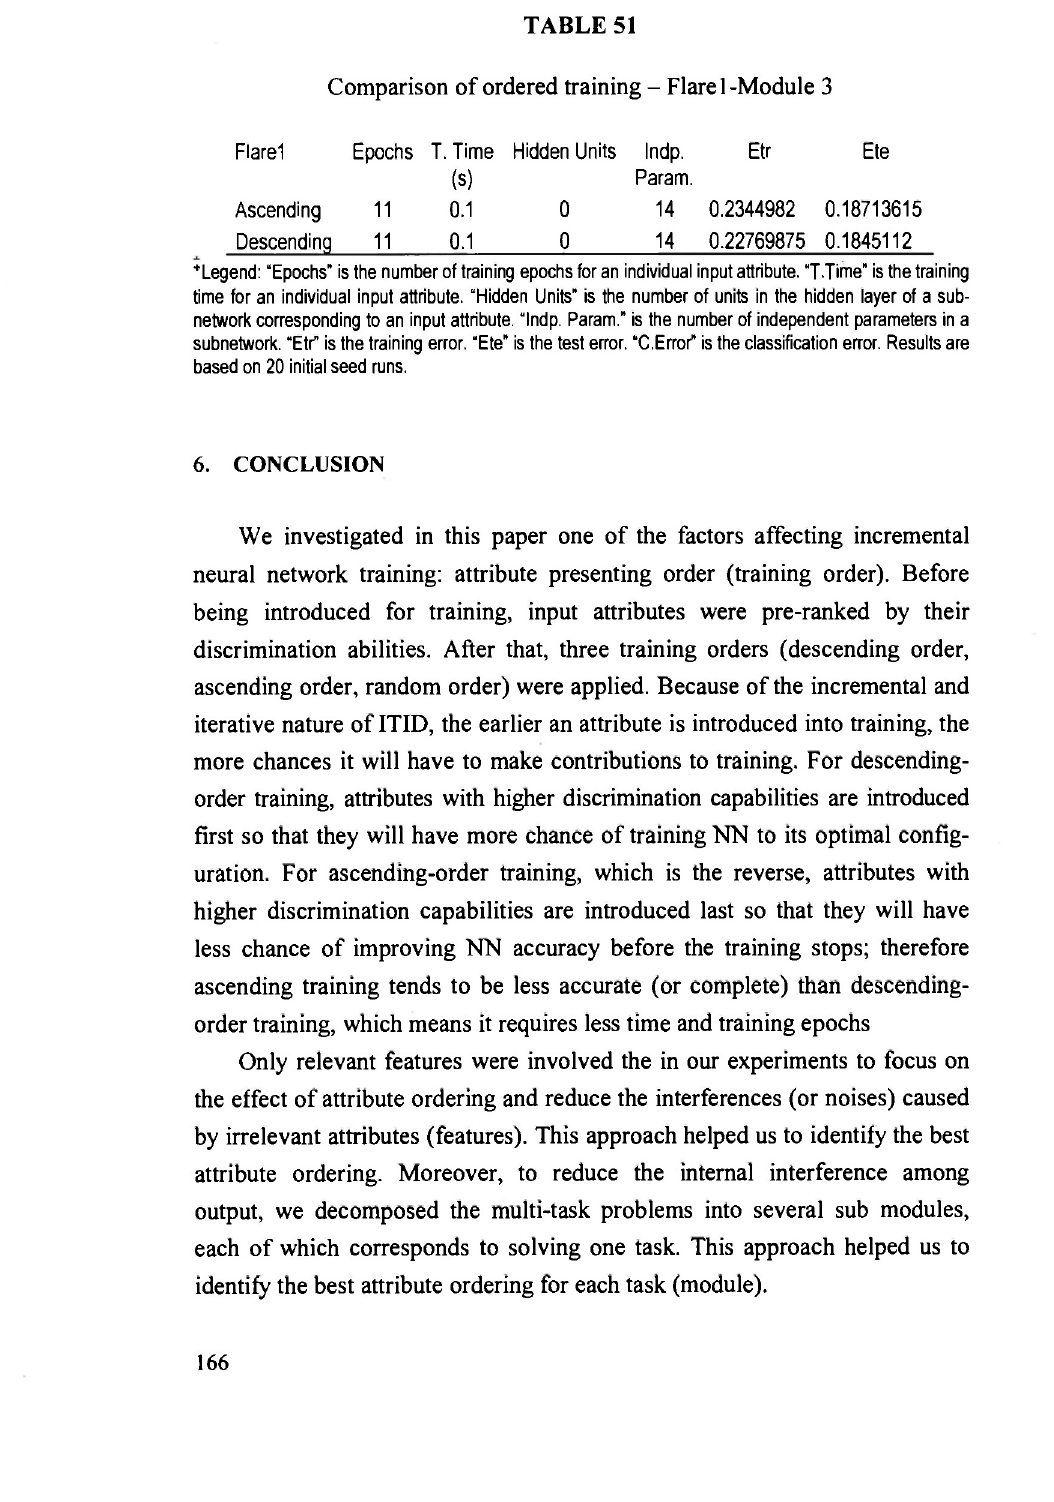
Comparison of ordered training - Flare 1-Module